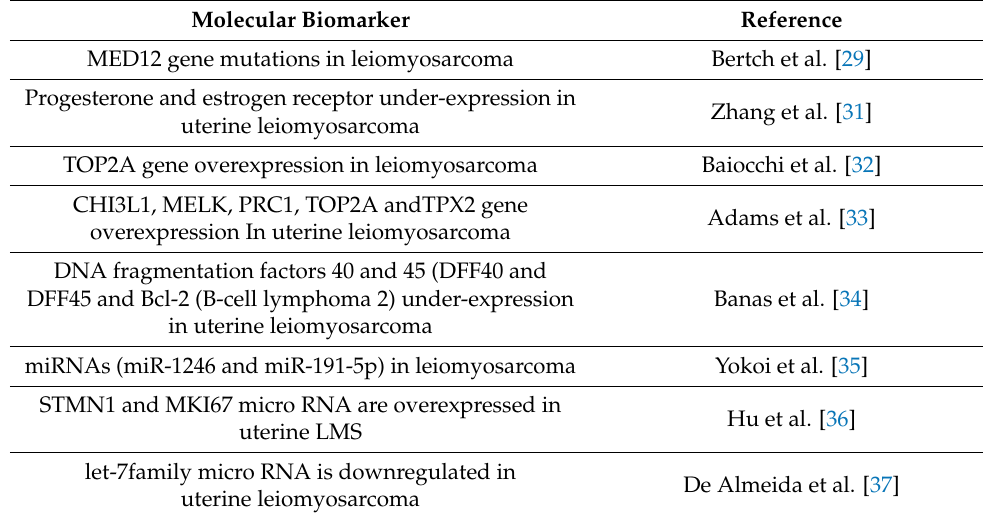
Table 1. Potential molecular biomarkers for differential diagnosis between uterine LMSand